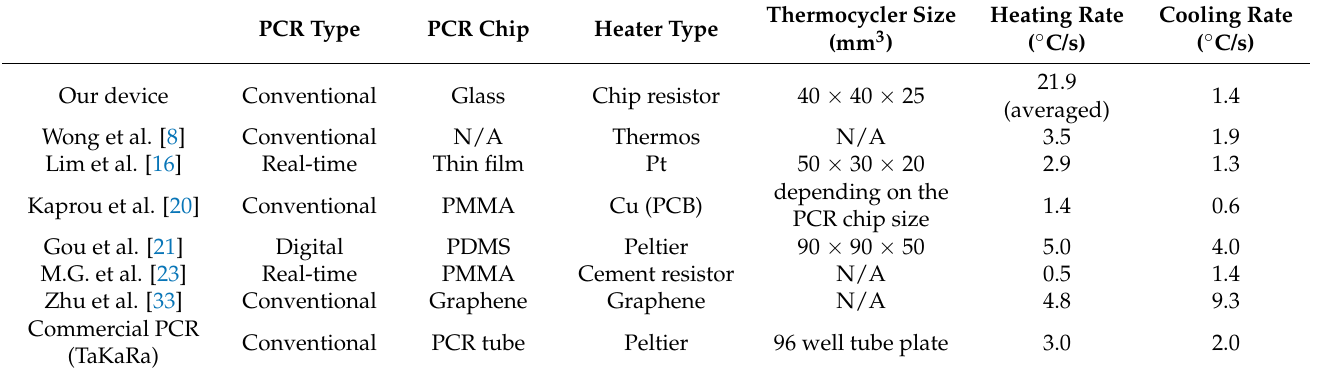
Figure 8. Measured PCR thermocycling profile with PID control. Table 4. Comparison of thermocycle type, size, and